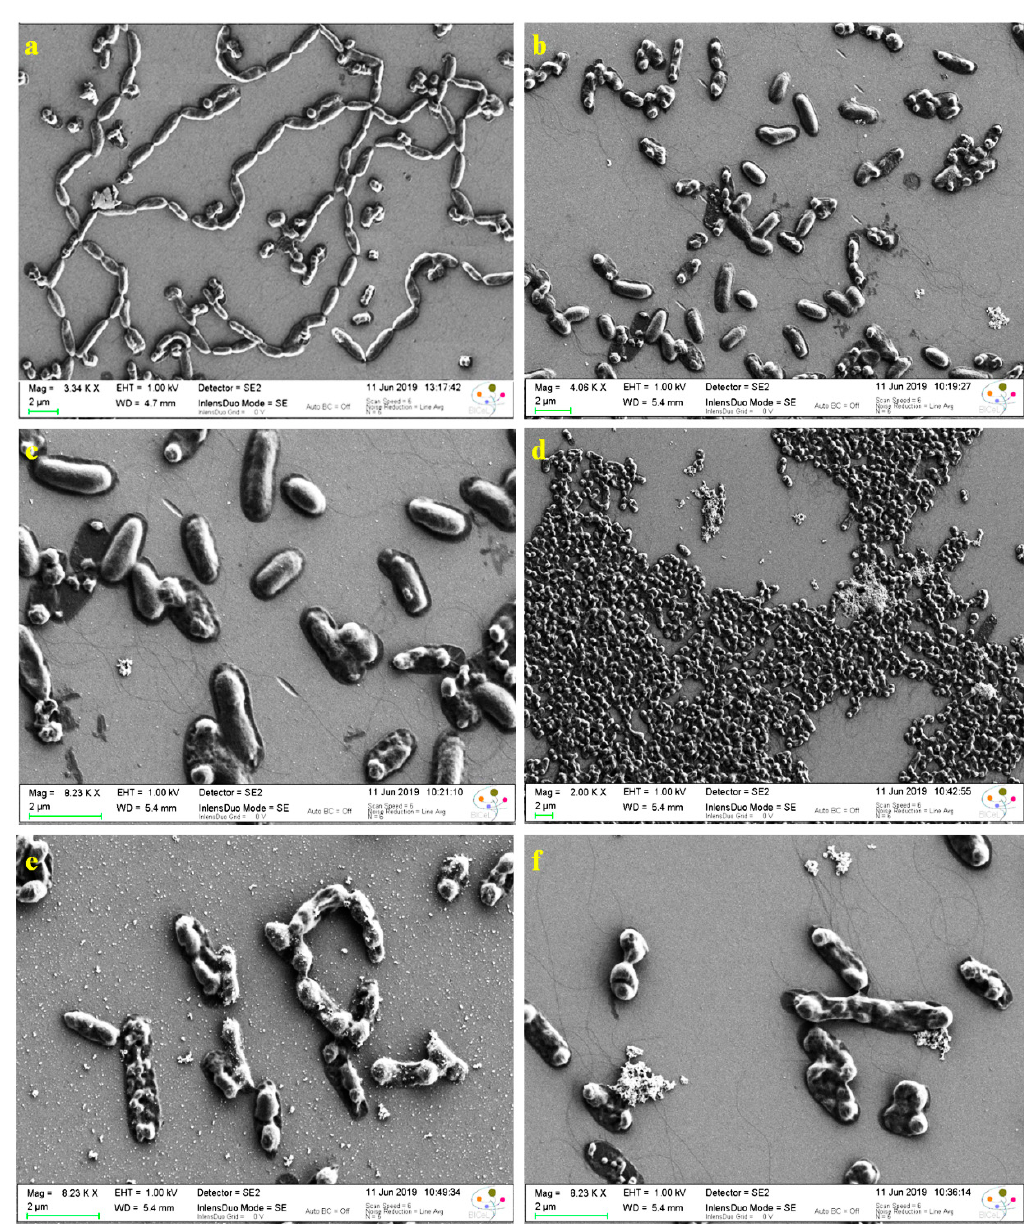
Figure 9. SEM images of E. coli : ( a ) control and incubated with CuS-BSA/lysozyme nanoparticles at a concentration of 100 µg/mL − 1 ( b , c ) without and ( d – f ) under 980 nm (1 W cm − 2 ) irradiation.